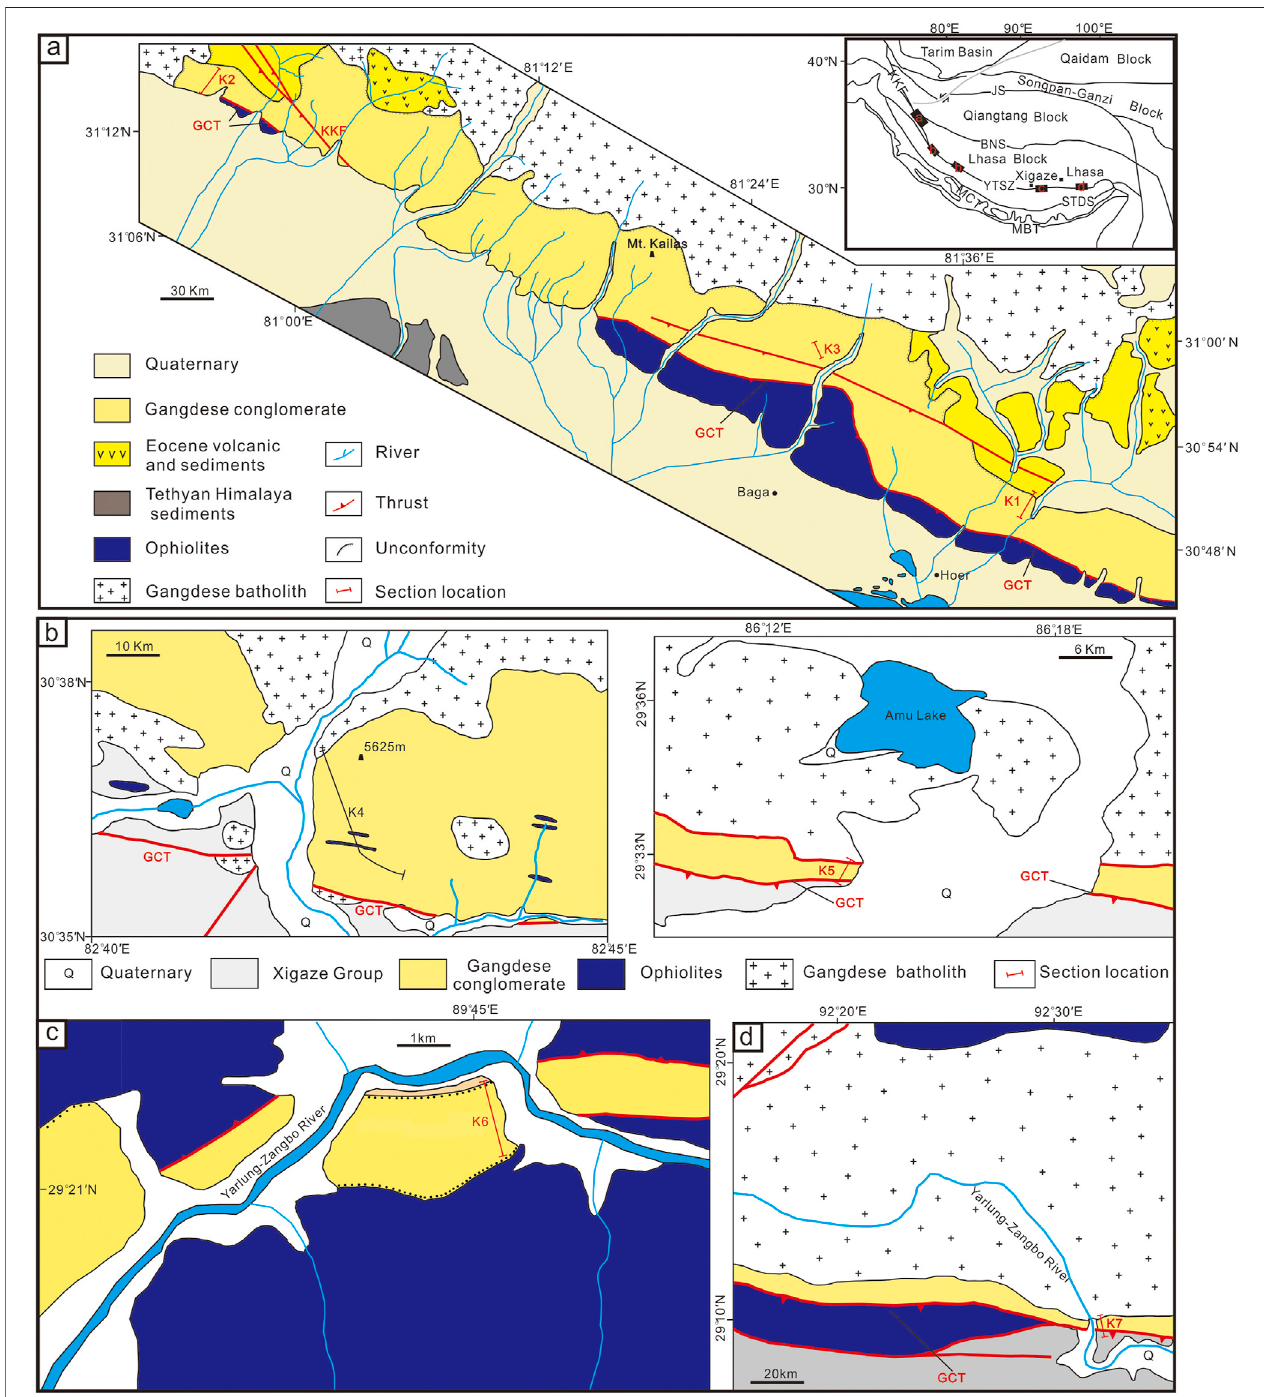
FIGURE 2 | Detailed geological map of study area showing locations of measured sections. (A) Geologic map of Kailas area; (B) geologic map of Mayoumu and Sangsang area; (C) geologic map of Xigaze area; (D) geologic map of Zedang area. Major faults: Main Frontal Thrust; MBT, Main Boundary Thrust; MCT, Main Central Thrust; STDS, South Tibetan Detachment System; GCT, Great Counter Thrust; KKF, Karakoram Fault. Major sutures: YTSZ, Yarlung-Zangbo suture zone; BNS, Bangong-Nujiang suture; JS, Jinshajiang suture.